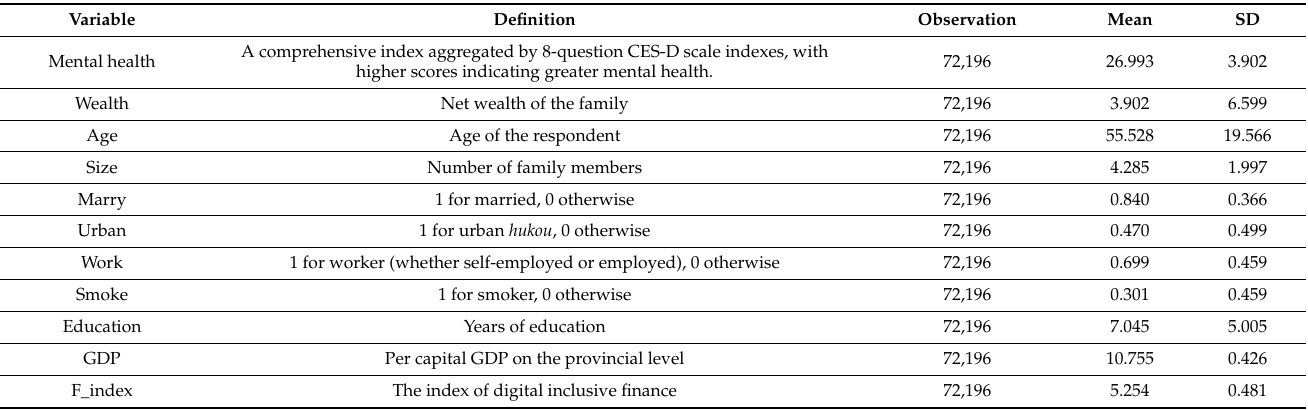
Table 1. Definition of